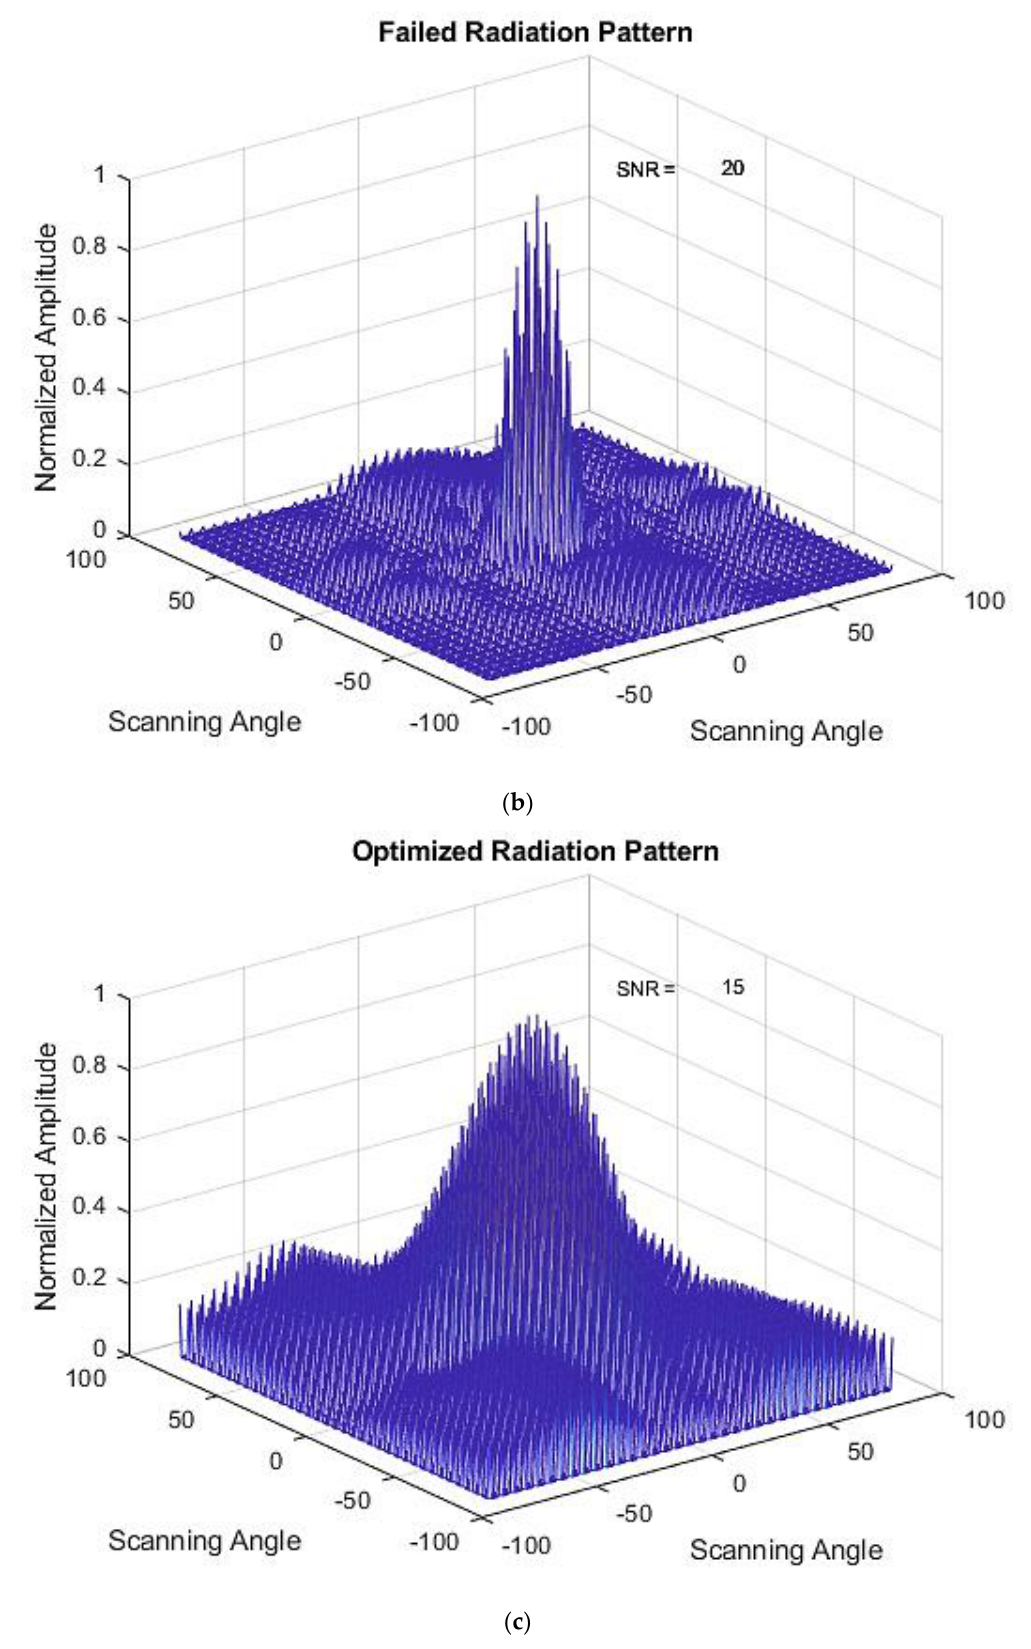
Figure 8. ( a ) Initial Radiation Pattern for the GA method. ( b ) Failed Radiation Pattern for the GA method. ( c ) Optimized Radiation Pattern for the GA method.